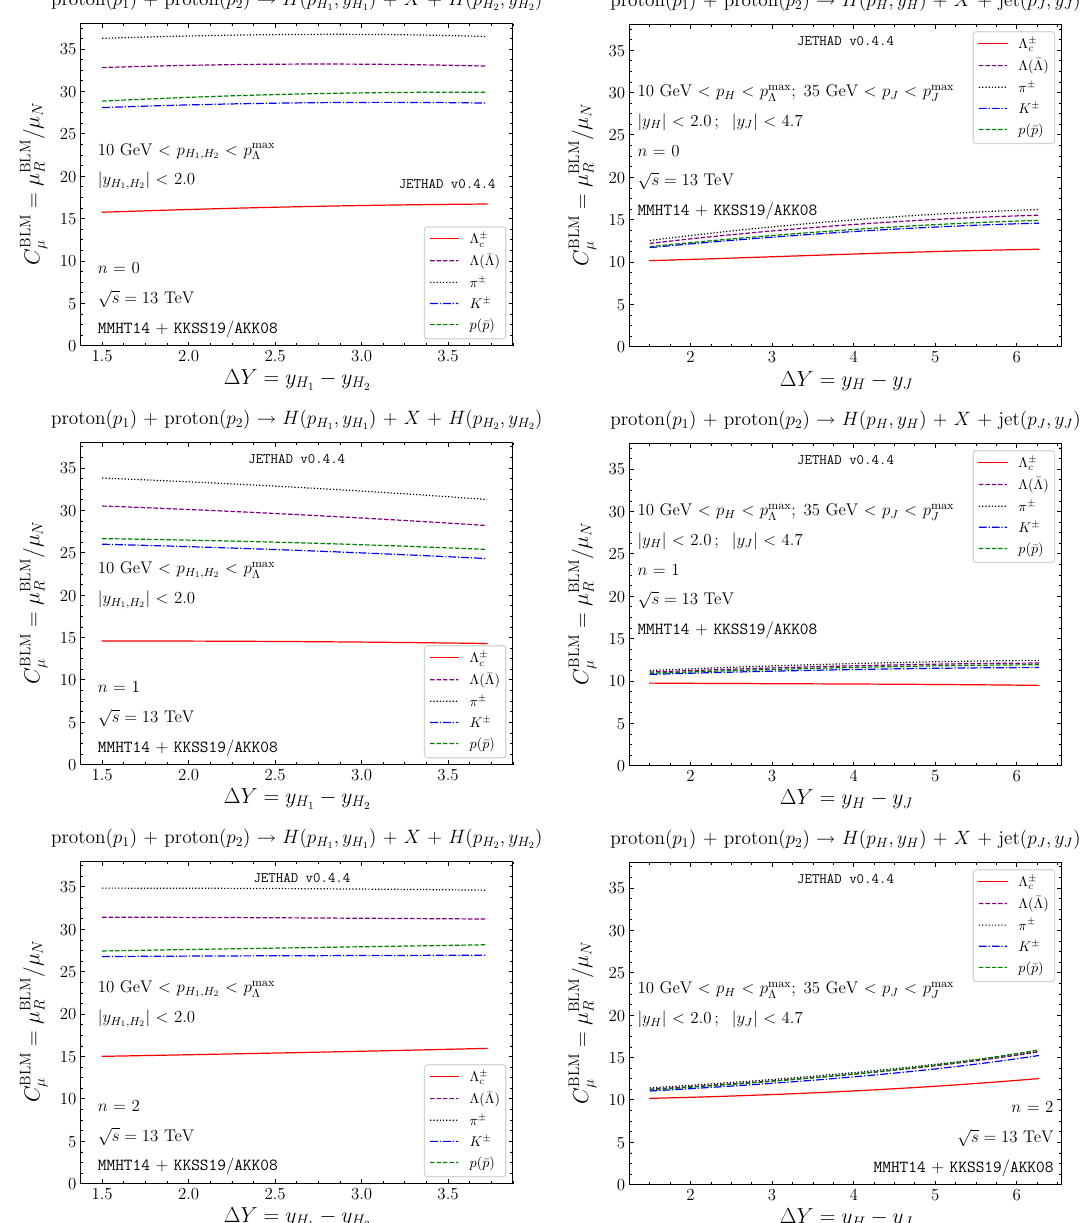
Fig. 2 BLM scales for the double (cid:2) c (left) and the (cid:2) c plus jet (right) production as functions of the rapidity separation, (cid:5) Y , for n = 0 , 1 , 2, √ s = 13 TeV. Predictions for (cid:2) c emissions are compared with and for